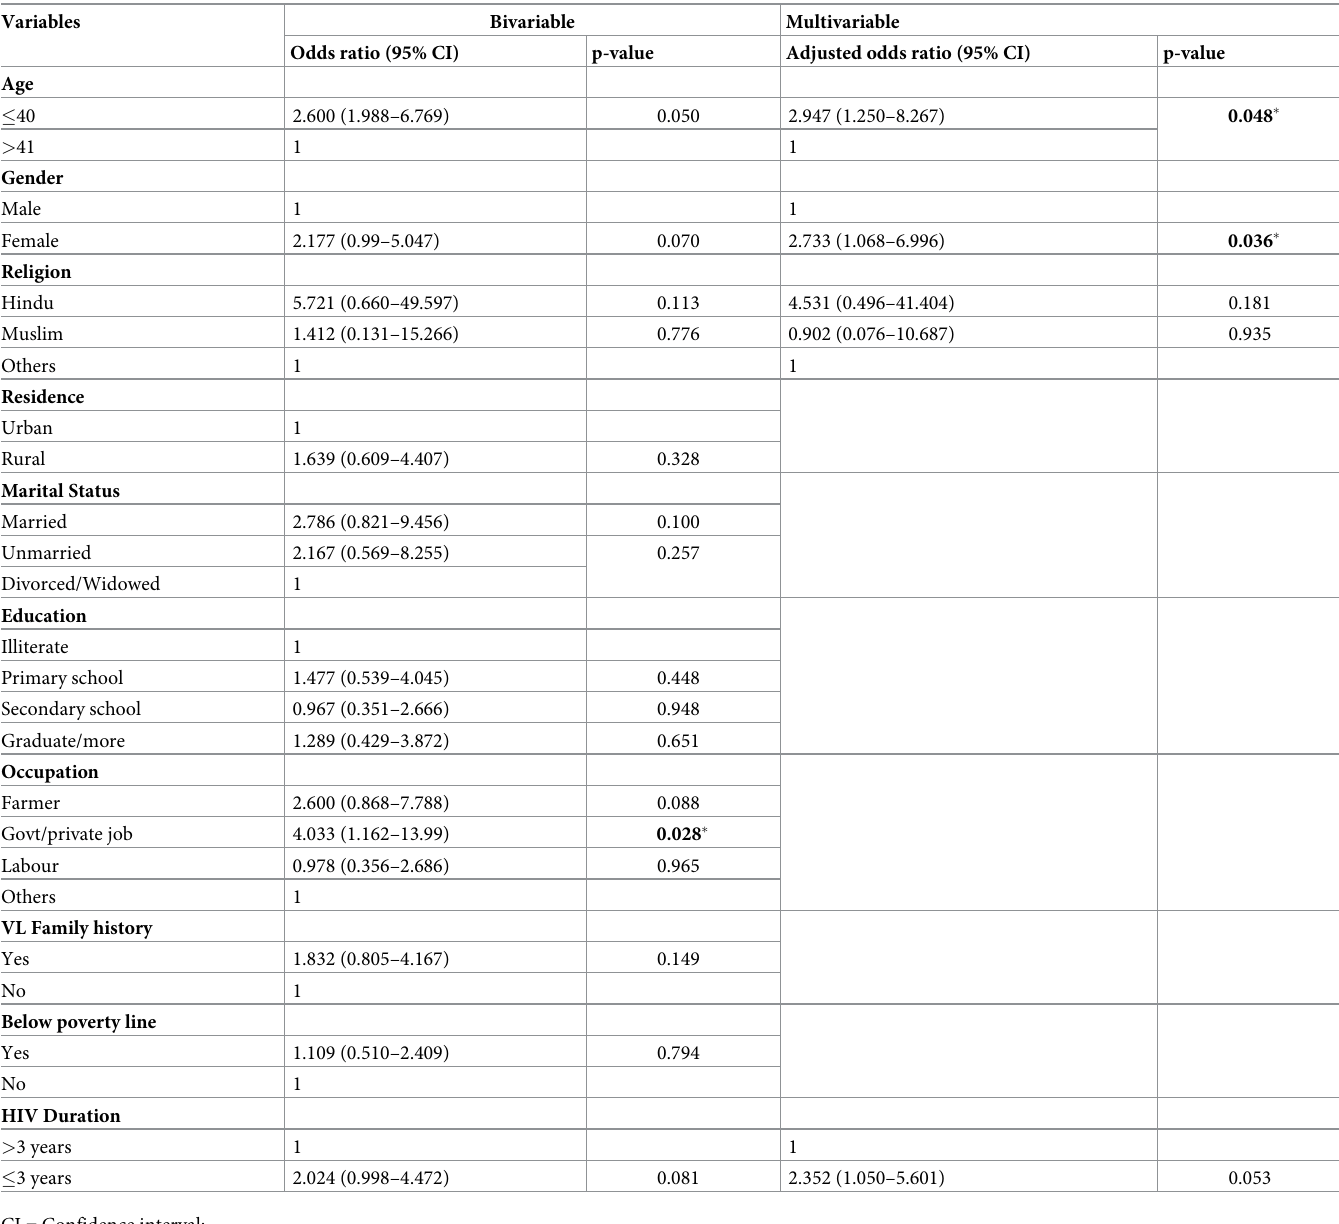
Table 5. Bivariable and multivariable logistic regression analysis showing predictors of attitude